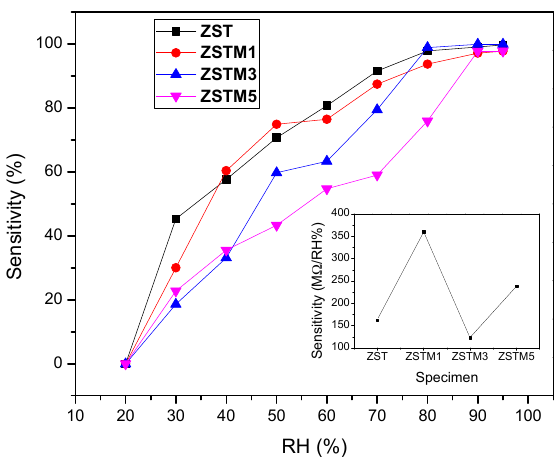
Figure 3. Sensitivity comparison between sensors at different humidity levels, and Inset; based on samples at entire RH range (from 20% to